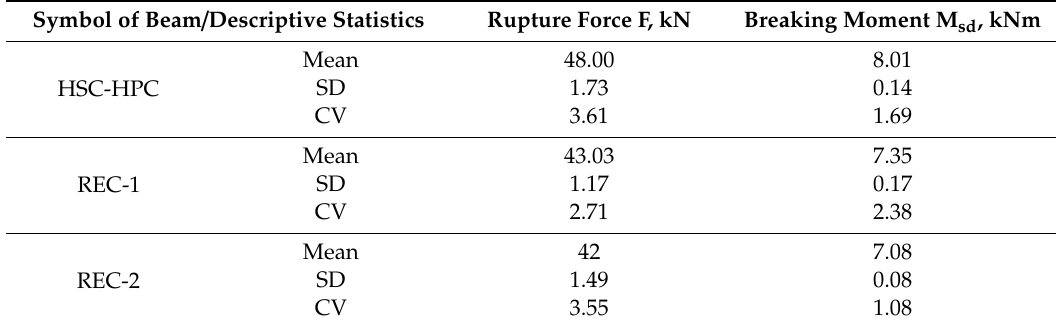
Coe ffi cient of variation—CV (%), Standard